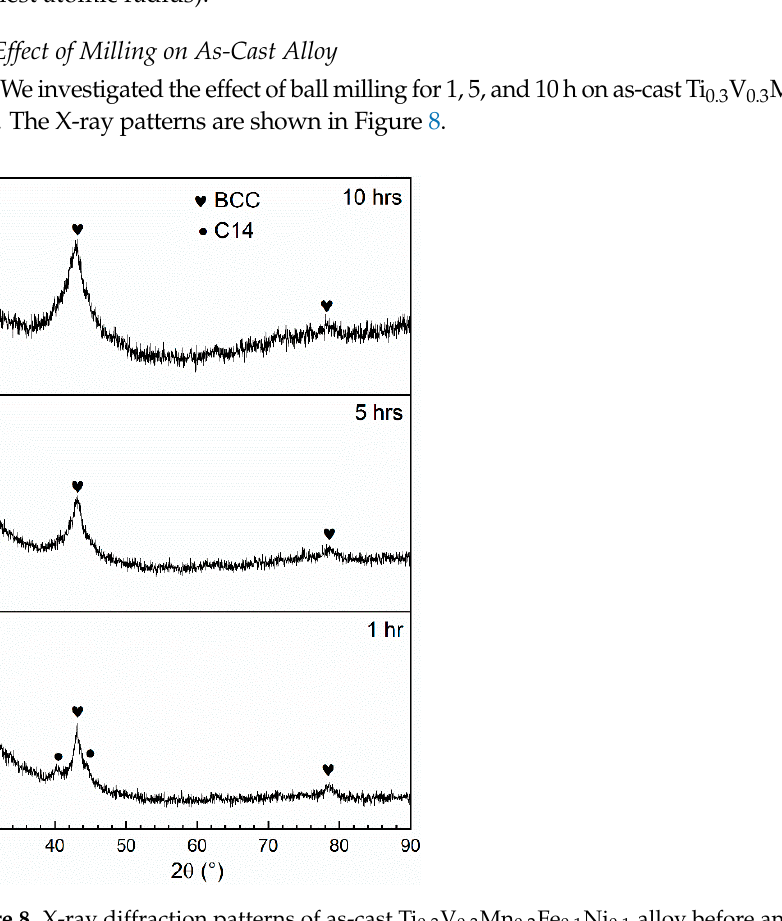
1, 5, and 10 h. for